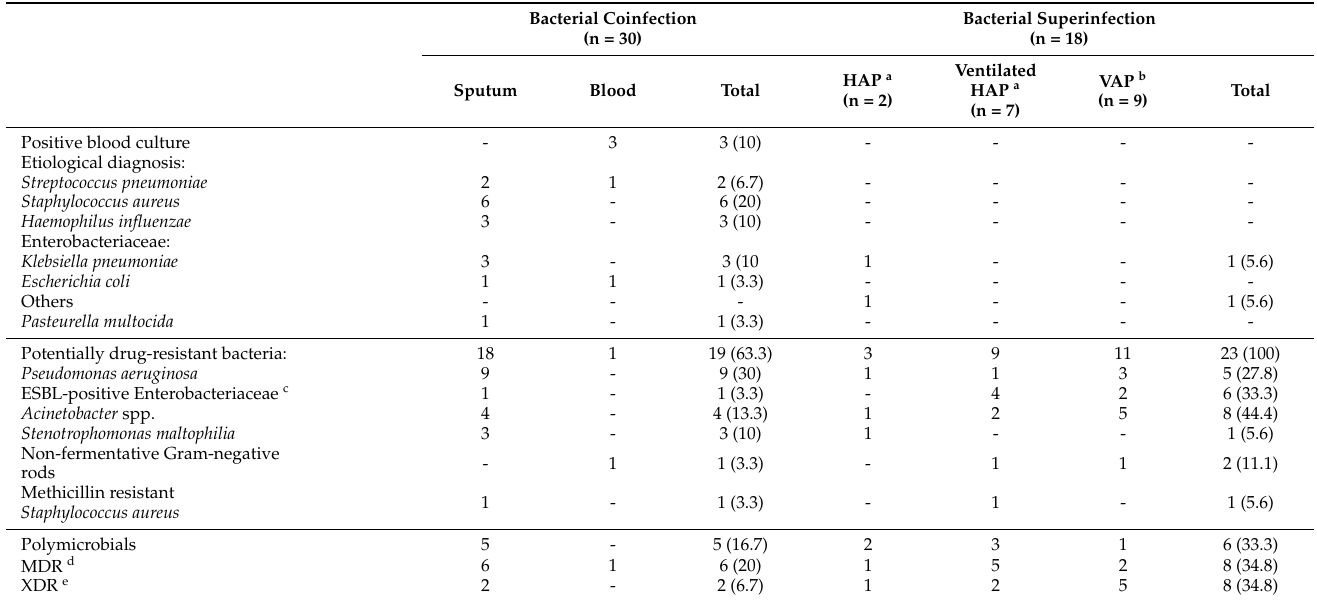
Table 4. Causative pathogens of bacterial coinfection and bacterial superinfection. Bacterial Coinfection (n =